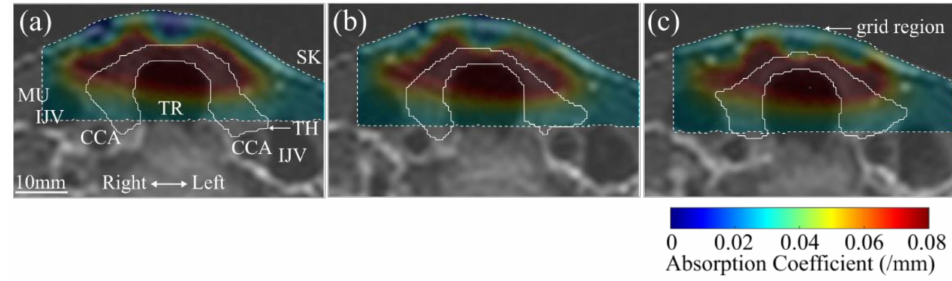
Figure 6. Same as Figure 4 but for the homogeneous